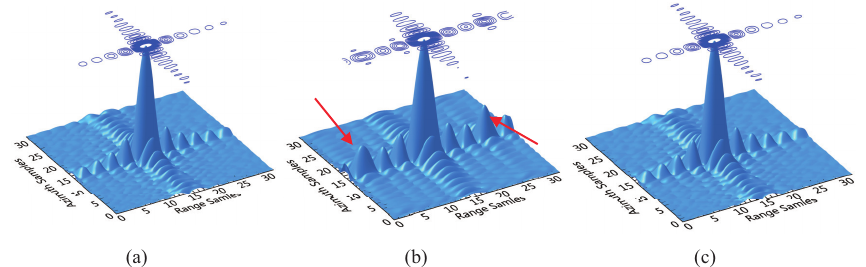
Figure 9. Magnified image of a point target in the focused results. ( a ) Processing result with FFBP; ( b ) processing result with Block_FFBP. The two red arrows note that the third sidelobe of the point processed using Block_FFBP are incorrect. ( c ) Processing result with MoBulk_FFBP.